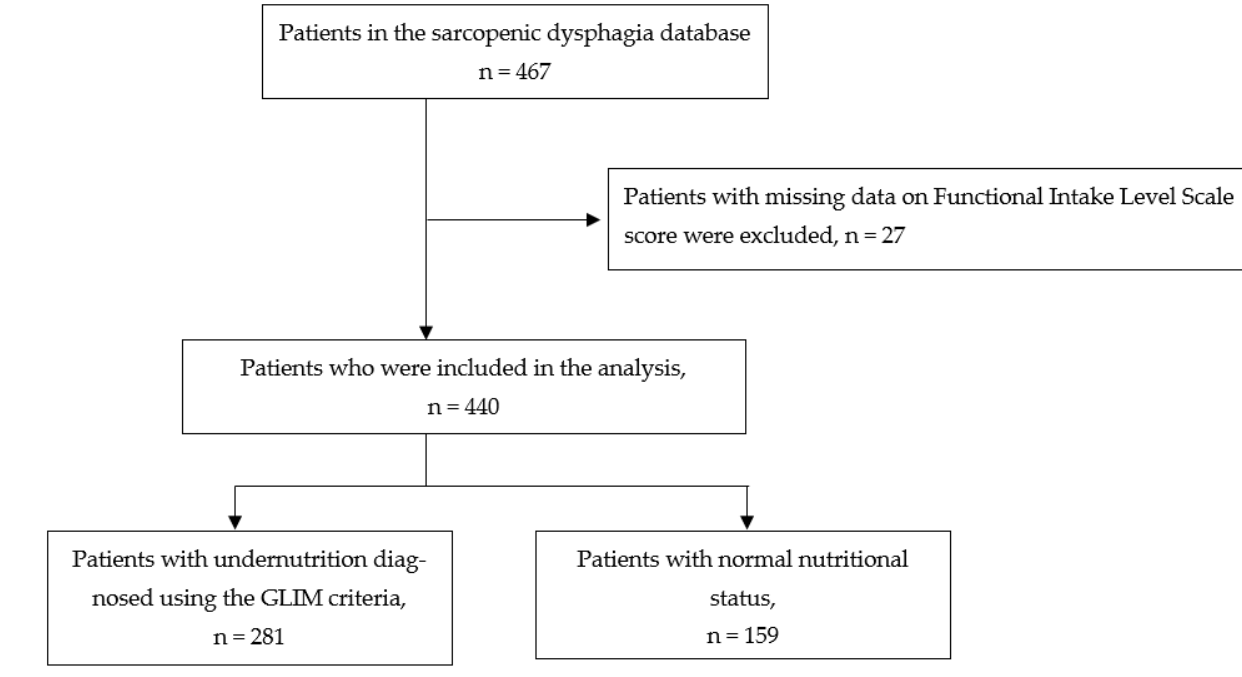
Figure 1. A flowchart of participant selection.